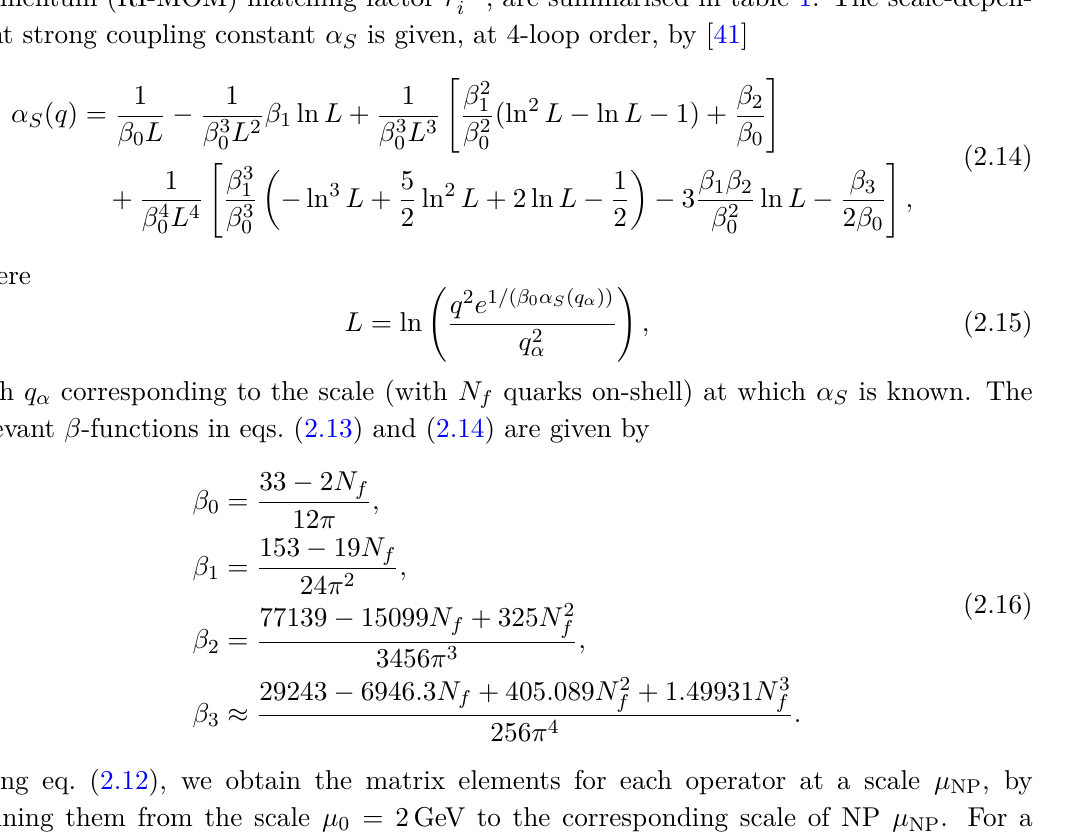
taken from [17] and i